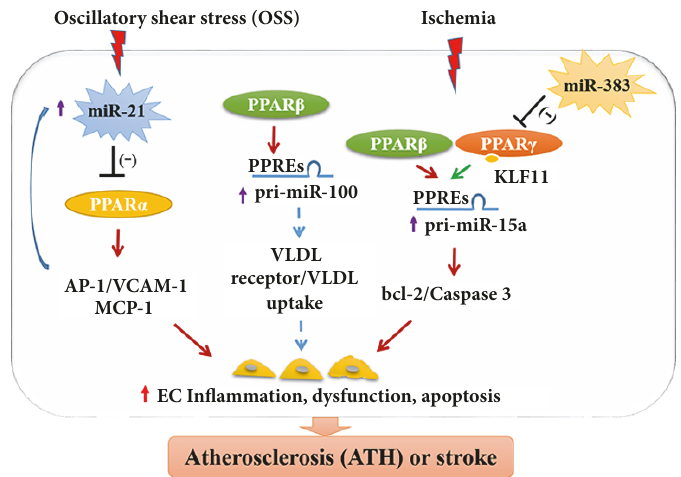
Figure 2: The regulatory function of microRNAs/peroxisome proliferator-activated receptors (PPARs) axis in the pathophysiology of atherosclerosisand stroke. EC: endothelialcell;AP-1: transcription factor activator protein-1; VCAM-1: vascularcelladhesion molecule-1;MCP-1: monocyte chemotactic protein-1; VLDL: very low-density lipoprotein; KLF11: Kruppel like factor